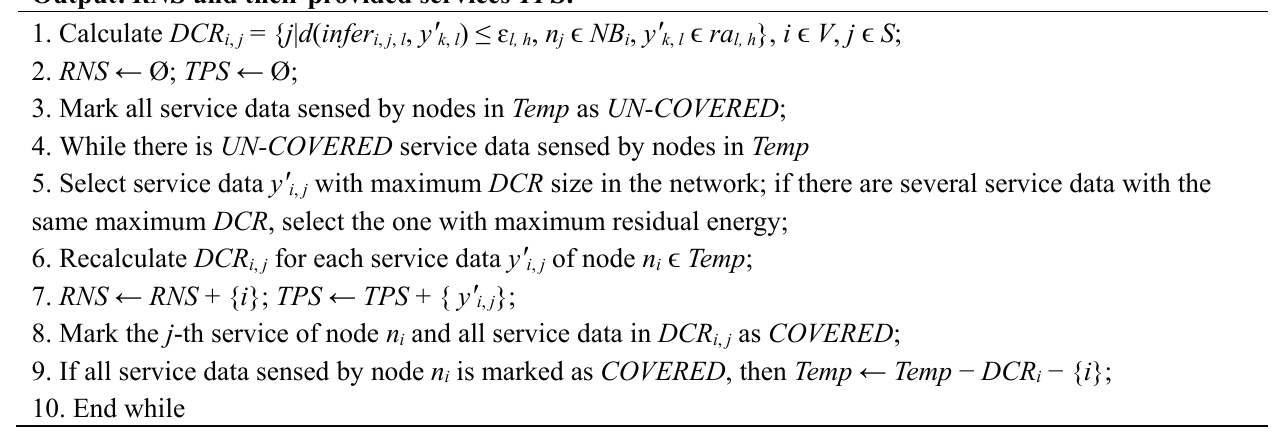
Algorithm 2. Multi-service Representative node selection and Service Determination (RSD)